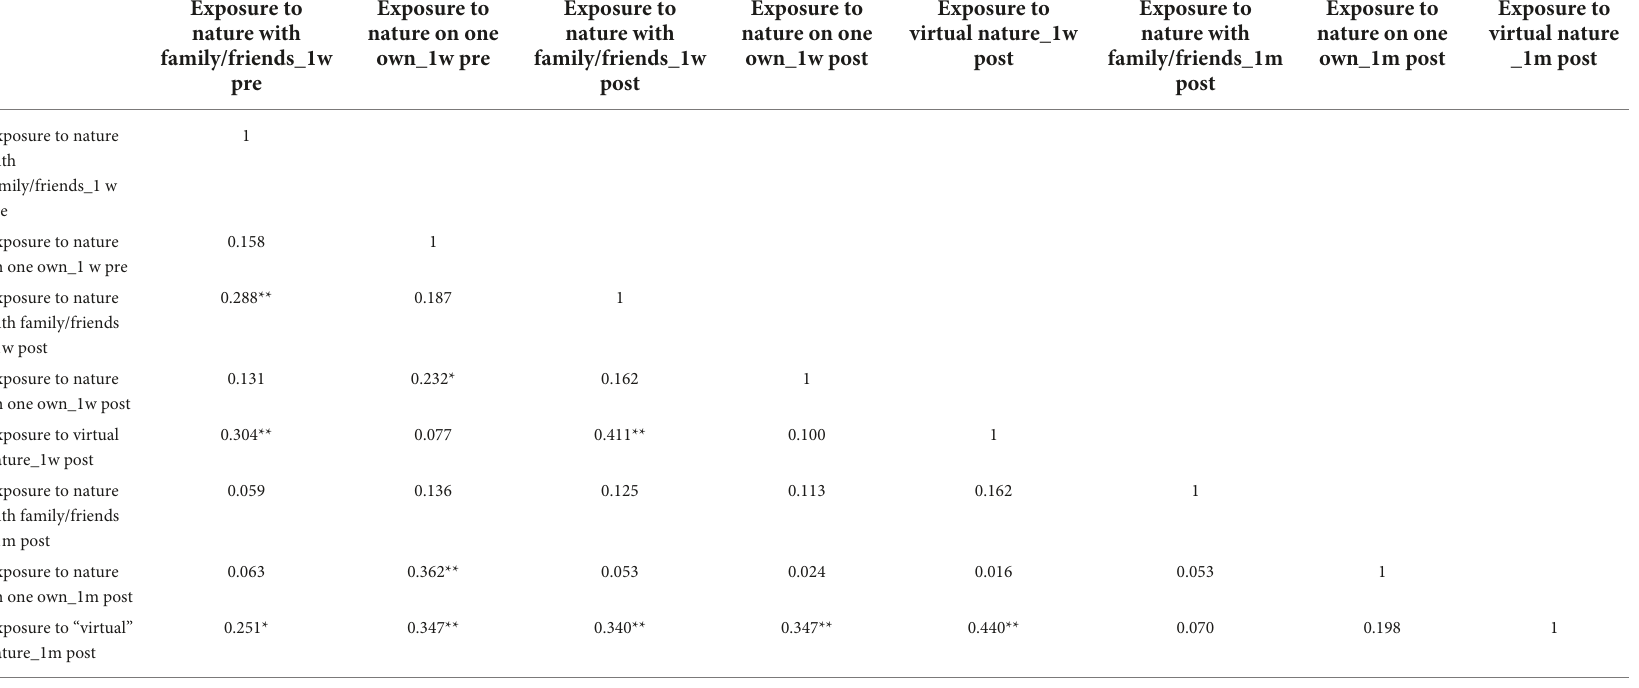
Exposure to virtual nature _1m